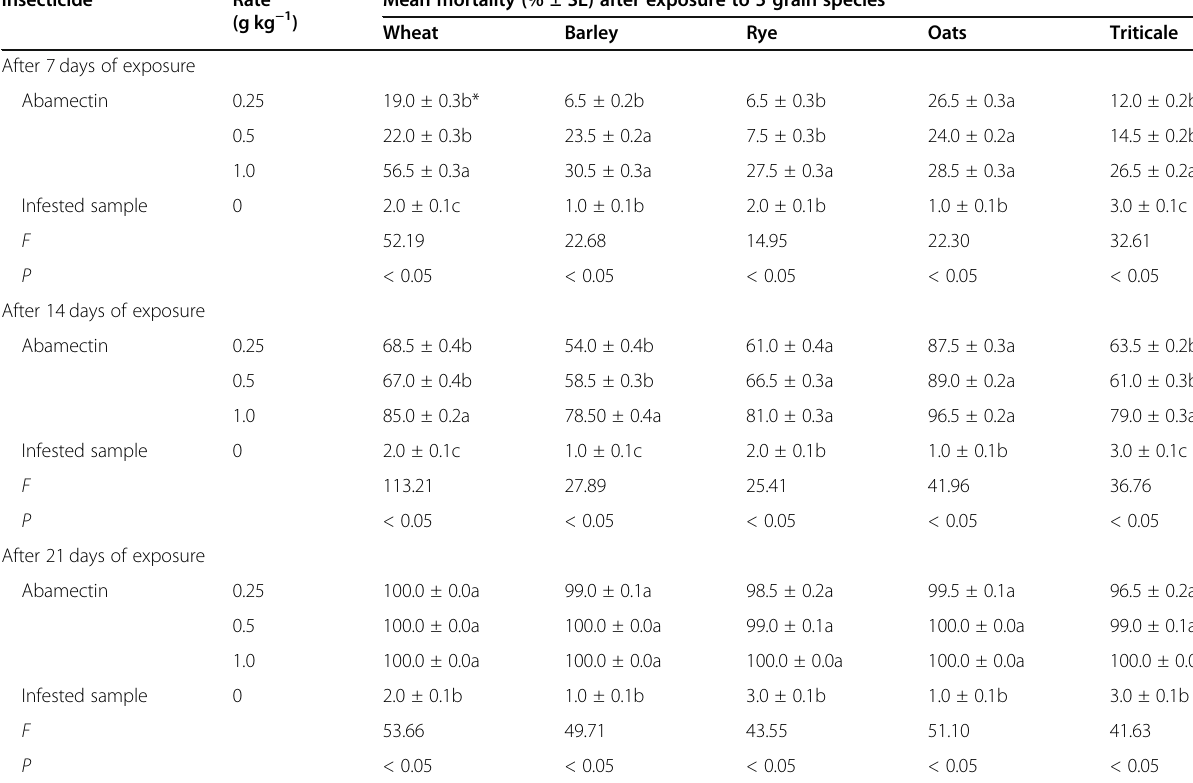
Table 2 Mortality rates of Rhyzopertha dominica after 7, 14, and 21 days of exposure to 5 grain species treated with abamectin Mean mortality (% ± SE) after exposure to 5 grain species Insecticide Rate (g kg − 1 ) Wheat Barley After 7 days of exposure Abamectin